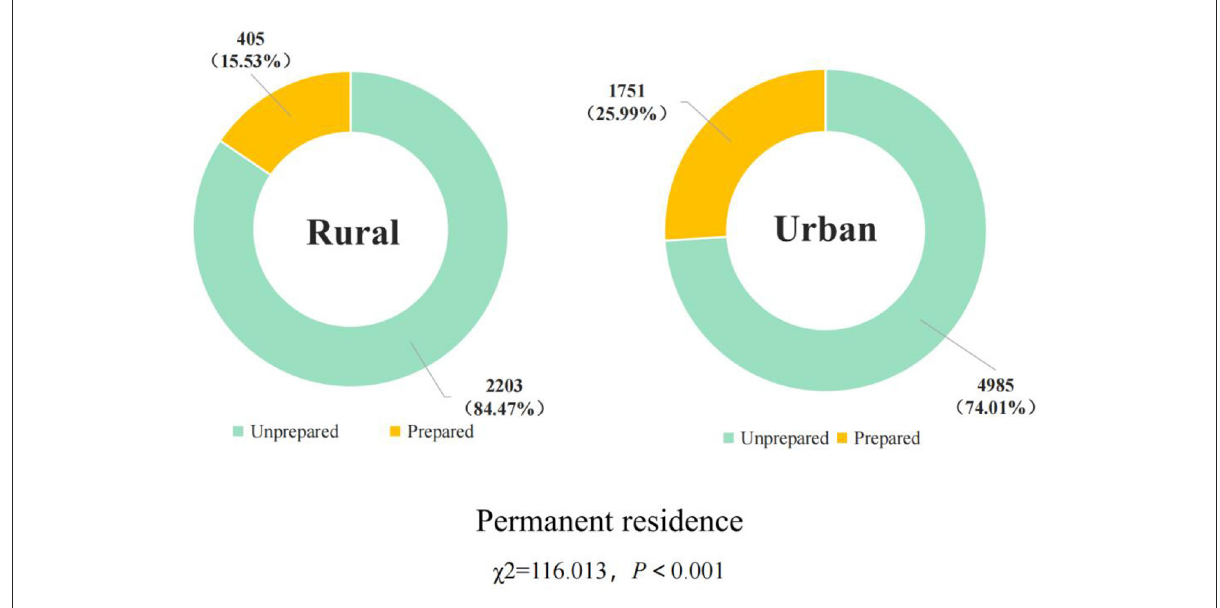
FIGURE2 Preparation of home first-aid kit by permanent residence.